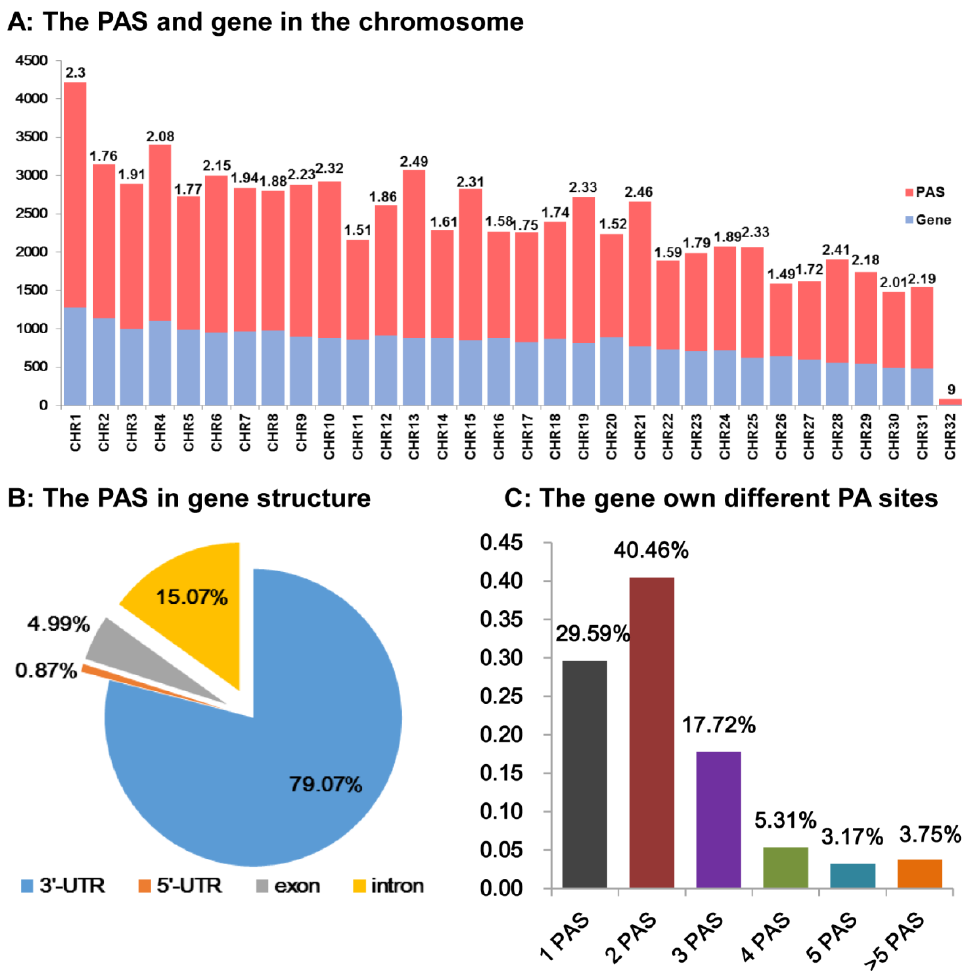
Figure 3. The APA in Spodoptera frugiperda . ( A ) The gene number, PAS site number, and ratio of PAS site to the gene on a particular chromosome. We analyzed the distribution of genes and PAS on the chromosome. We chose the color red to symbolize the PAS number and the color blue to represent the gene’s number on the chromosome. ( B ) The position of the PAS inside the gene structure. We investigated the frequency of PAS in the 3 (cid:48) UTR, 5 (cid:48) UTR, exon, and intron of genes. ( C ) The proportion of Spodoptera frugiperda genes that have multiple poly (A) sites. Y -axis was the ratio of gene with PA sites to total gene. We counted the number of PAS sequences present in each annotated gene and divided them into six categories: 1, 2, 3, 4, 5, and >5 PAS